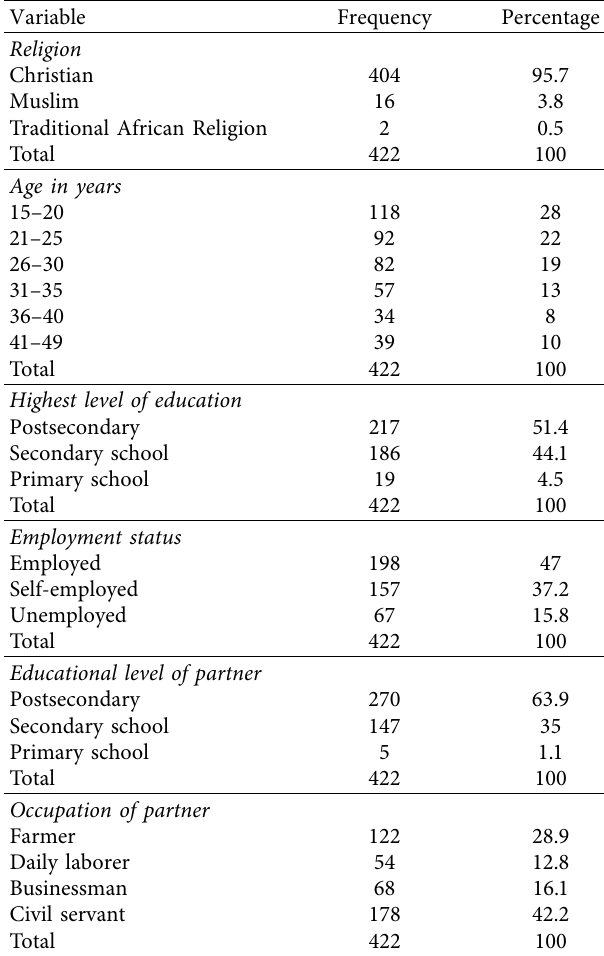
Table 1: Sociodemographic characteristics of respondents, N �